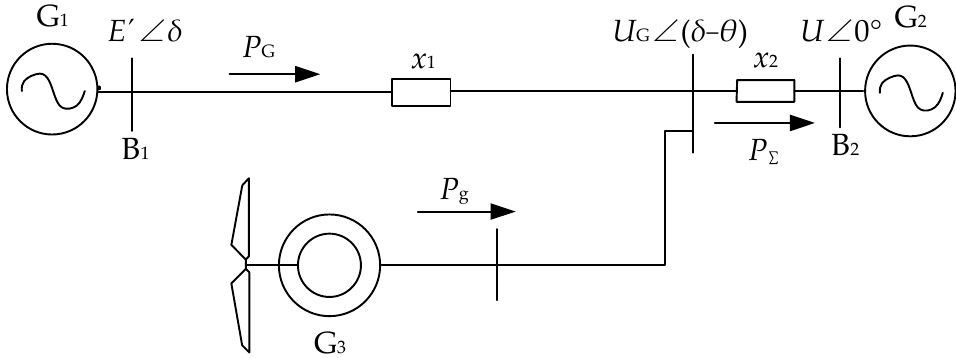
Figure 1. Active power control strategy of DFIG-based WTs under IC.